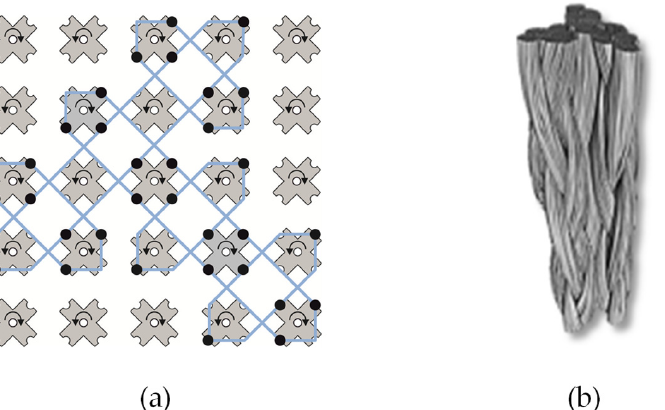
Figure 8. ( a ) Programming of bobbin configuration; ( b ) 3D braided textile preform in a T-profile- like geometry.